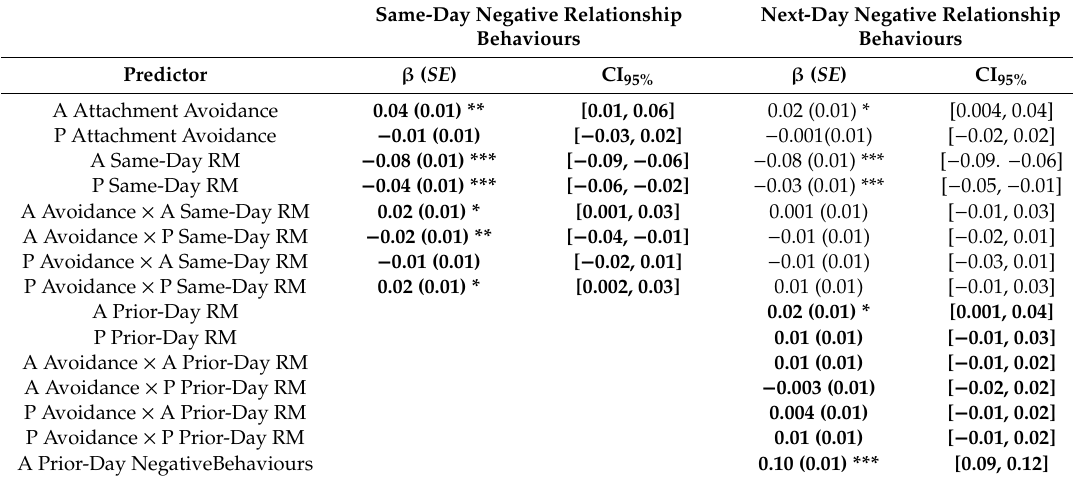
Table 4. Associations of attachment avoidance and daily relationship mindfulness with same-day and next-day negative relationship behaviours. Note. N = 100 couples. A = actor; P = partner; RM = relationship mindfulness. Higher scores on continuous variables represent greater standing on the variable (e.g., higher daily RM). For clarity, the key e ff ects in each model are in boldface. * p < 0.05, ** p < 0.01, *** p < 0.001.